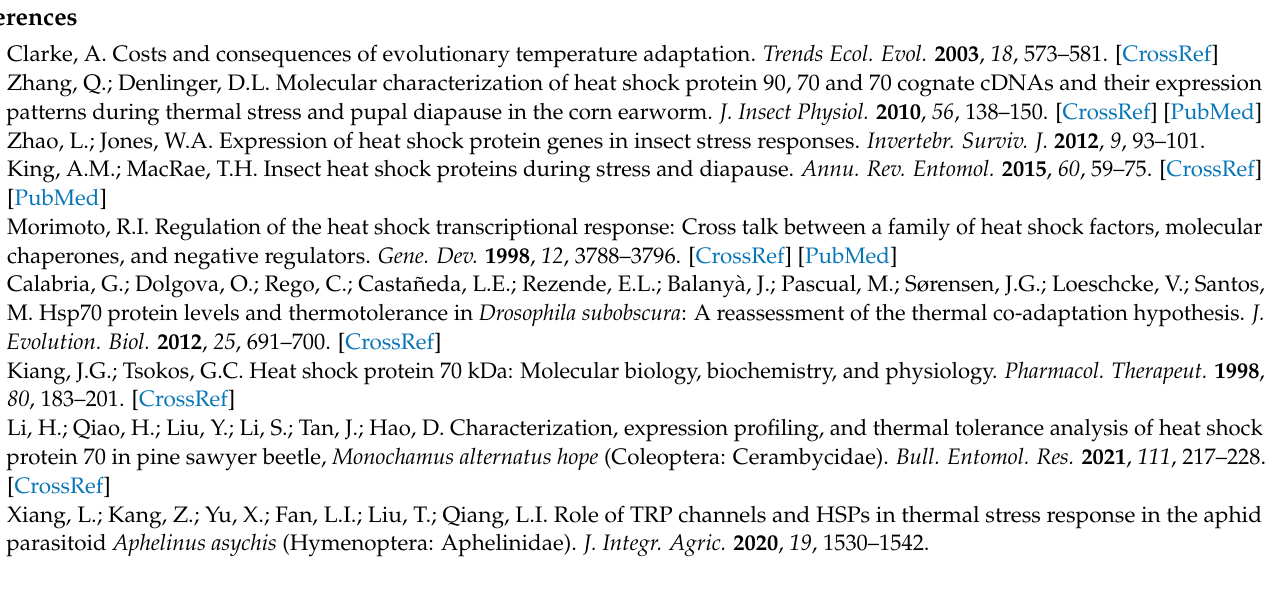
Figure S1: Nucleotide and deduced amino acid sequences of PmHsc70, Figure S2: Nucleotide and deduced amino acid sequences of PmHsp70a, Figure S3: Nucleotide and deduced amino acid sequences of PmHsp70b, Figure S4: Sequence alignment of PmHSC70 with HSP70 proteins of